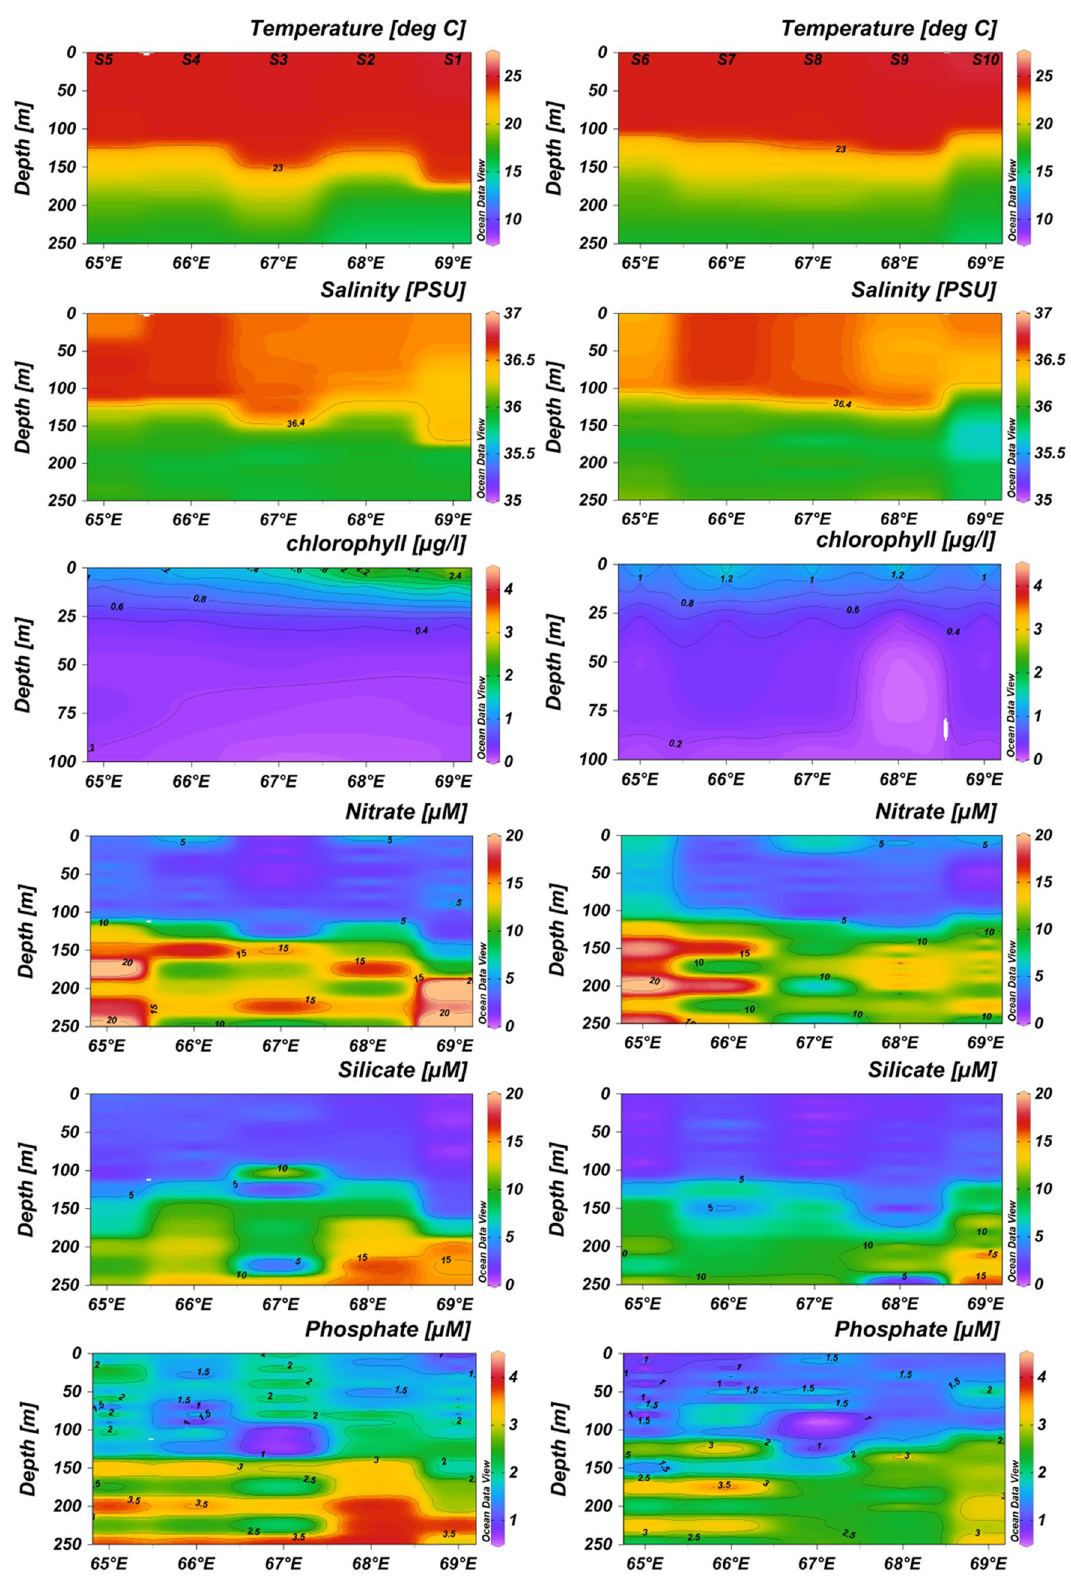
Figure 2. Vertical sections of Temperature (deg C), Salinity (PSU), chlorophyll (µg/l), Nitrate (µM), Silicate (µM) and Phosphate (µM) along 21°N (left panel) and 20°N (right panel) transects. Plots created using ODV 57